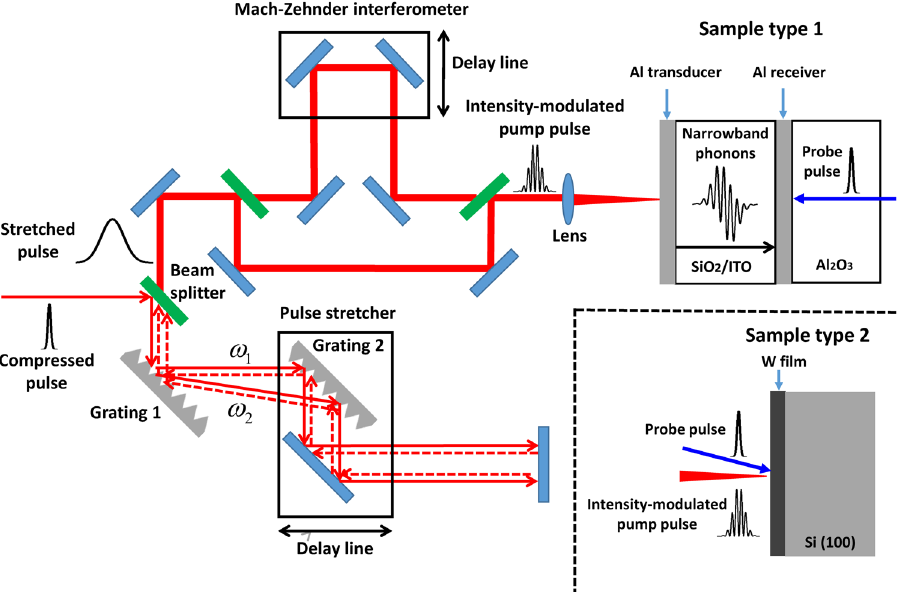
Figure 1. The scheme of spectrum-tunable narrowband acoustic phonon spectroscopy. Schematics of the experimental setup of the frequency and bandwidth tunable narrowband acoustic phonon spectroscopy using the intensity-modulated optical pump pulse. The sandwiched-layer sample (sample type 1) was used for the acoustic transport measurement by the opposite-side pump-probe geometry. The nanoscale W thin film (sample type 2) was used for the study of mechanical resonant eigen-mode excitation by the same-side pump- probe